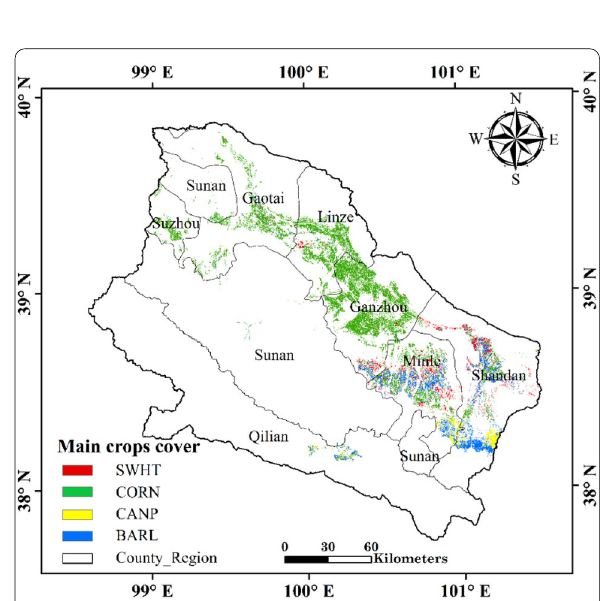
Fig. 2 Planting distribution of four main crops (corn, spring wheat, spring barley, and spring canola-Polish) in the upper and middle reaches of the Heihe River